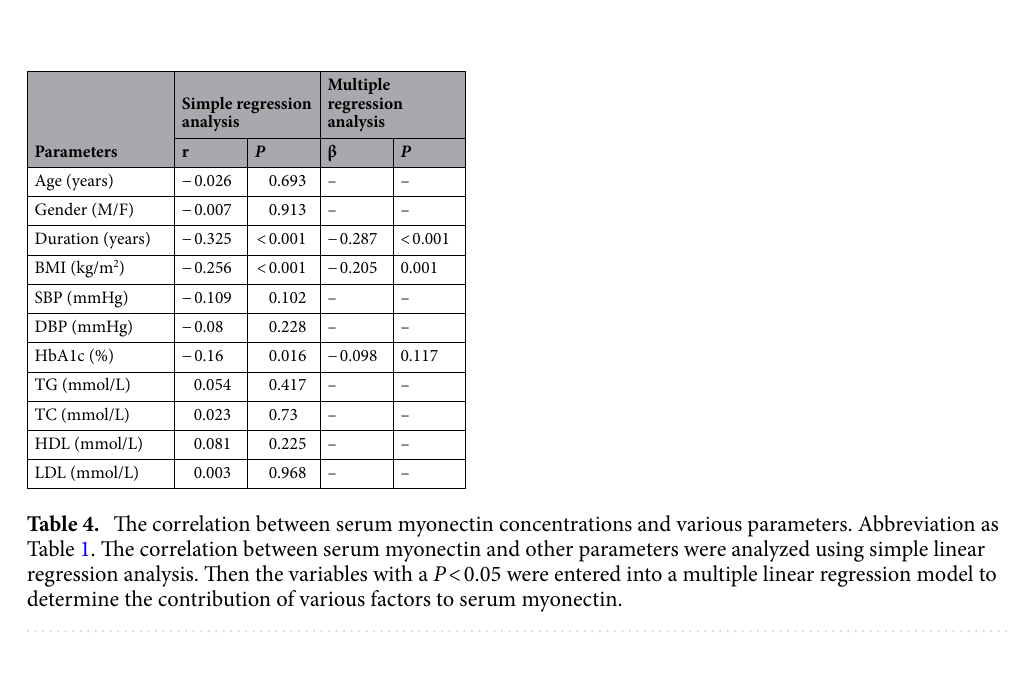
Table 3. Logistic regression analysis for determining the risk factors of developing DR. Abbreviation as Table 1. Univariate logistic regression analysis was performed and the variables with a P < 0.05 were then entered into a multivariate logistic regression model to assess the significant independent factors associated with DR.